Question: Describe this figure in one sentence.
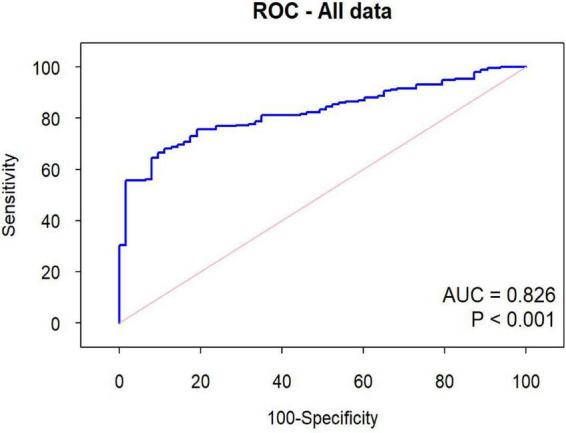
Answer: Receiver operating characteristic (ROC) curve of the frailty stratification model.